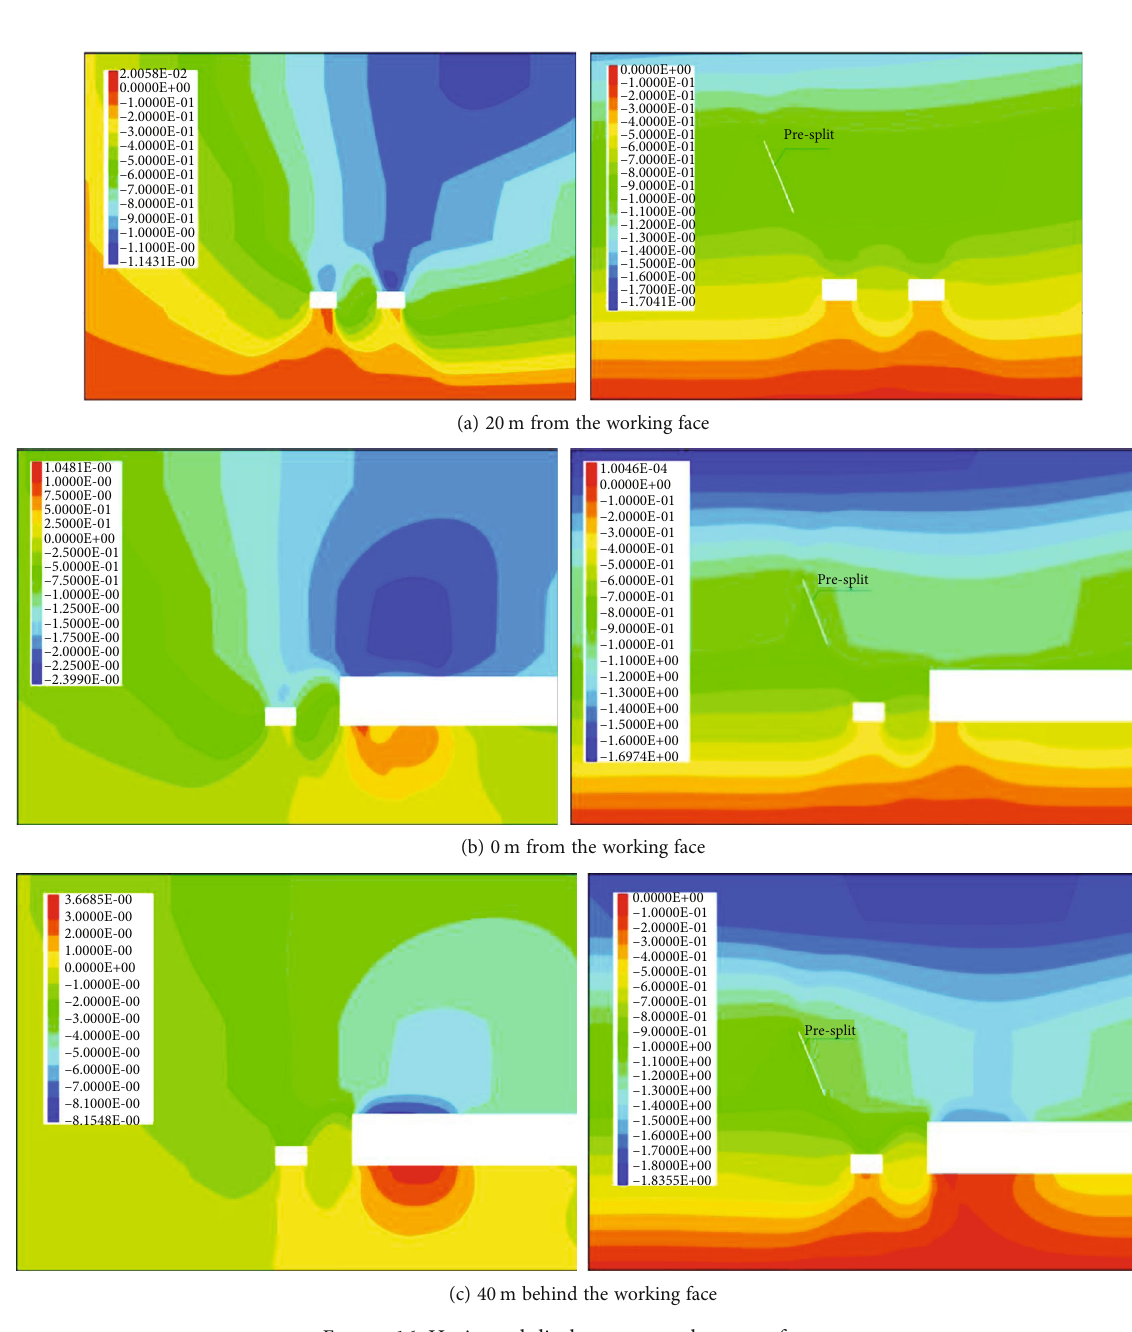
Figure 16: Horizontal displacement nephogram of